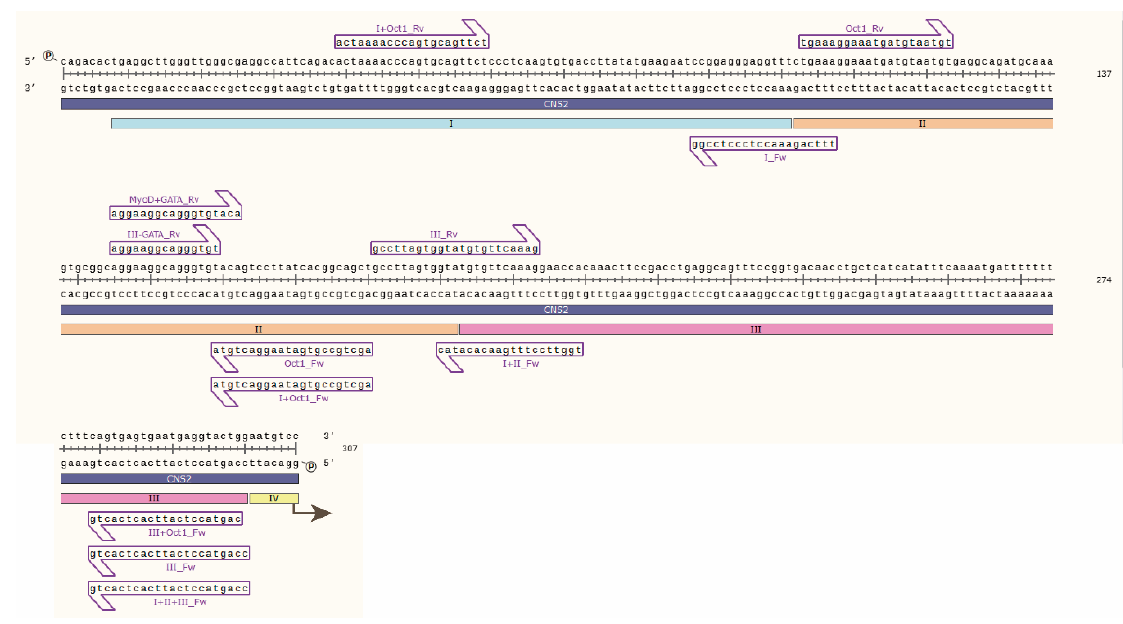
Figure 1: Sanger sequencing of mouse CNS2 sequence containing regions I, II and III. Primers used to